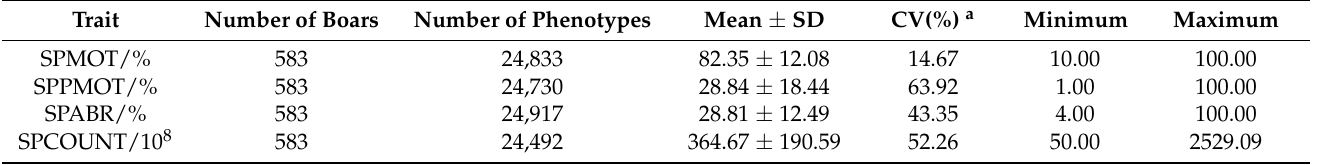
Table 1. Descriptive statistics for the semen traits of Duroc